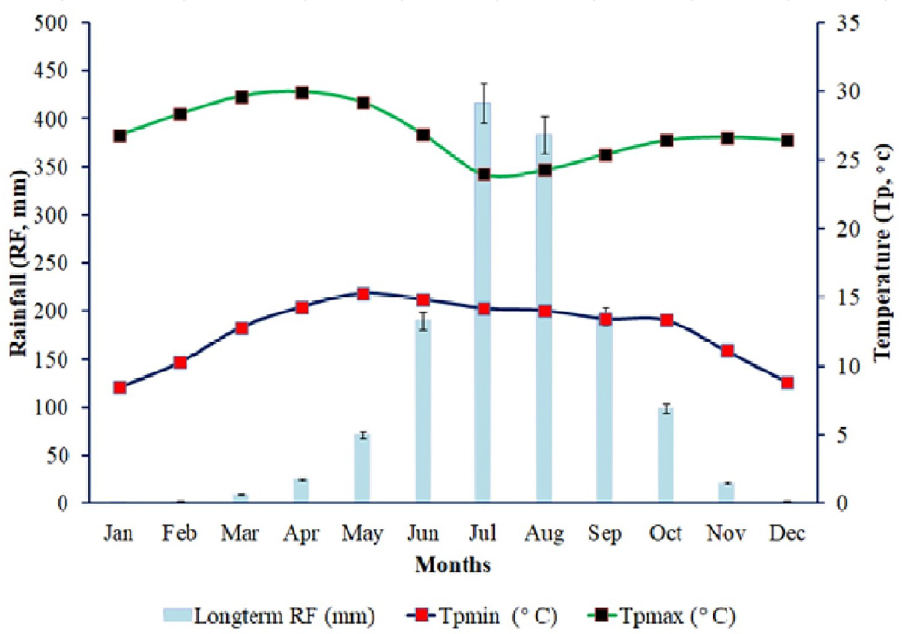
Fig 1. Long-term (1994–2021) monthly rainfall (RF), maximum temperature (Tpmax), minimum temperature (Tpmin) in the study